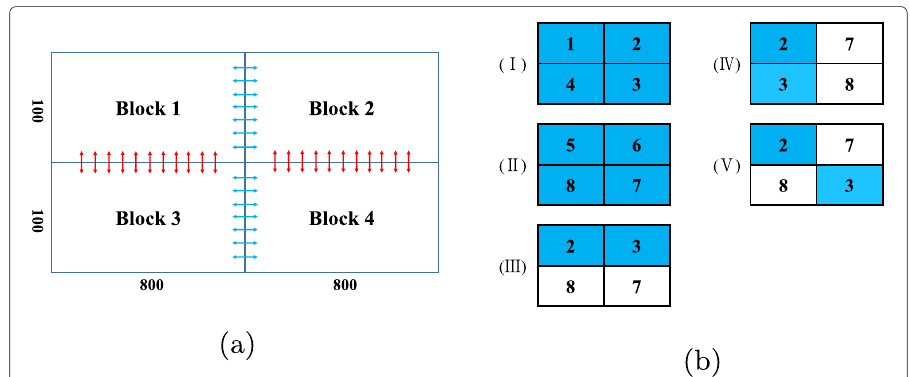
switch has 5 GPUs mounted on it. Hence there are two “PIX” GPU groups, GPU 0 ∼ 4 and 5 ∼ 9. And GPUs between the “PIX” groups are in relation to “PHB”. As we have introduced before, GPUs in “PIX” relation communicate faster than GPUs in “PHB” rela- tion. So putting processes that have large data transfer between each other in “PIX” group of GPUs will get higher communication efficiency. For better comparison, five cases are considered, as shown in Fig. 16b. For all cases, the blocks with the same color mean that